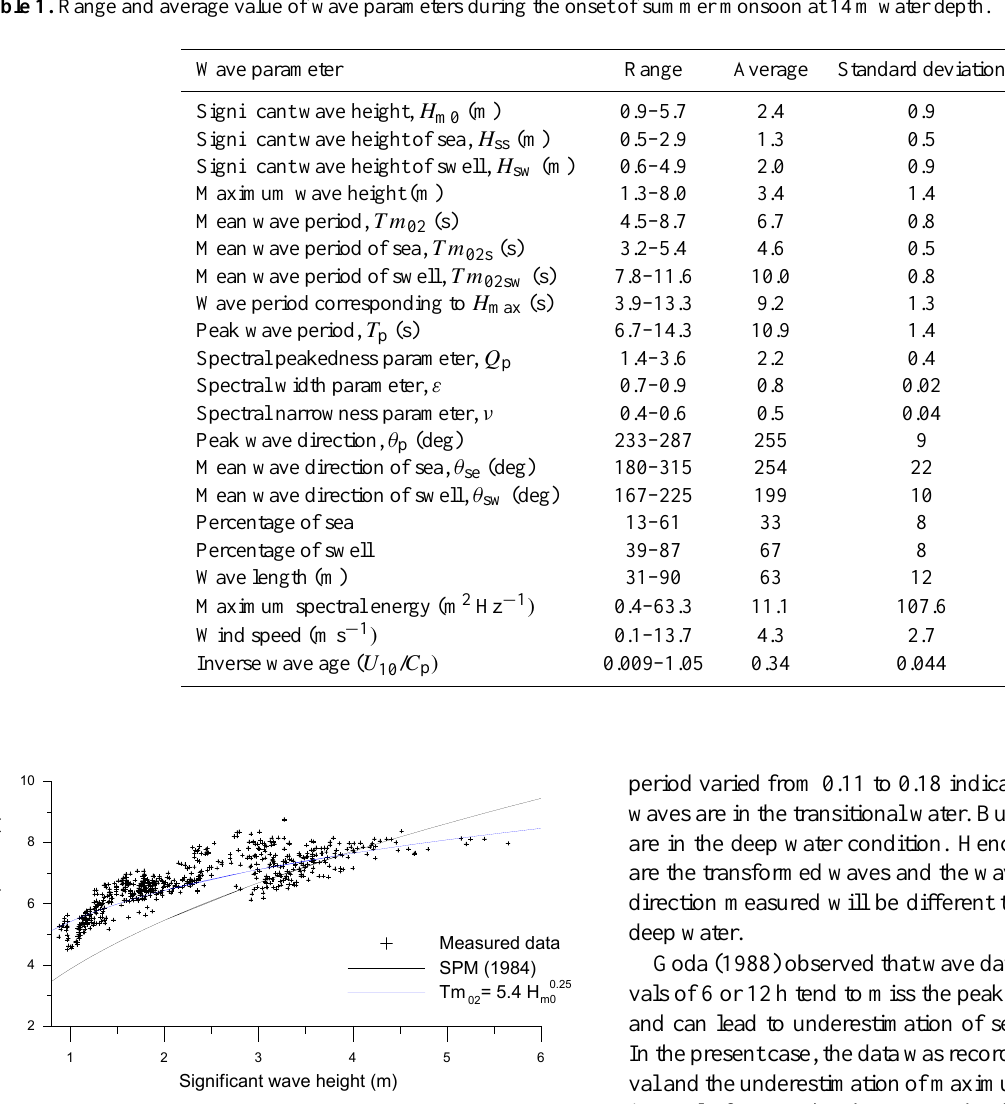
Figure 4. Variation in sea surface elevation during 27 to 29 May 2006 (for 62 h)